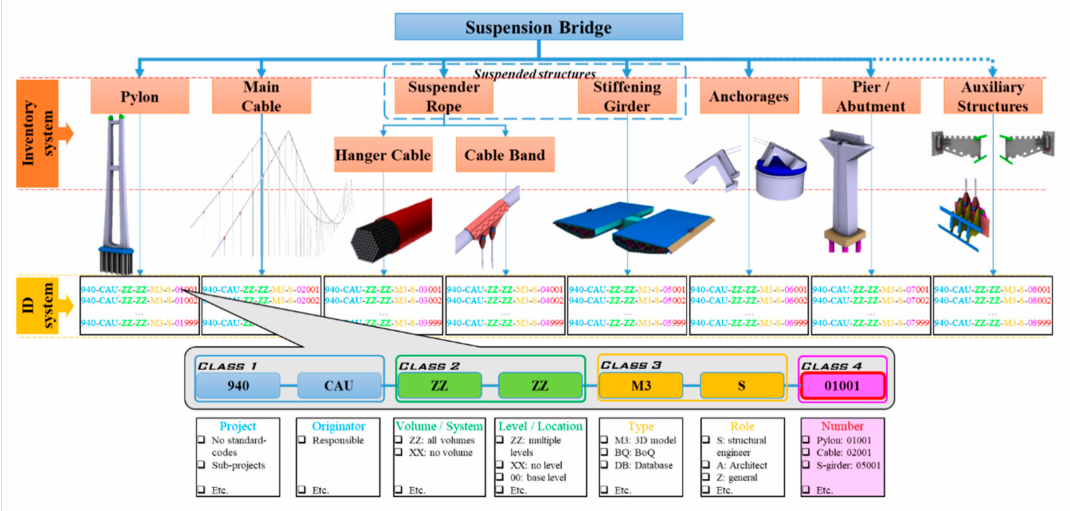
Figure 2. Suspension bridge inventory and ID